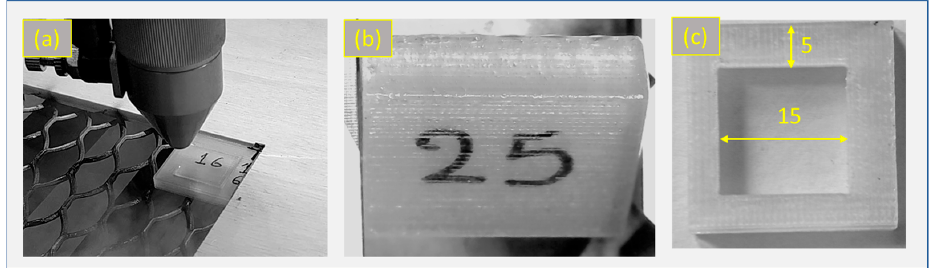
Figure 1. ( a ) Laser cutting work, ( b ) final cuboid part (15 × 15 mm No 25), and ( c ) remaining ring after cutting.